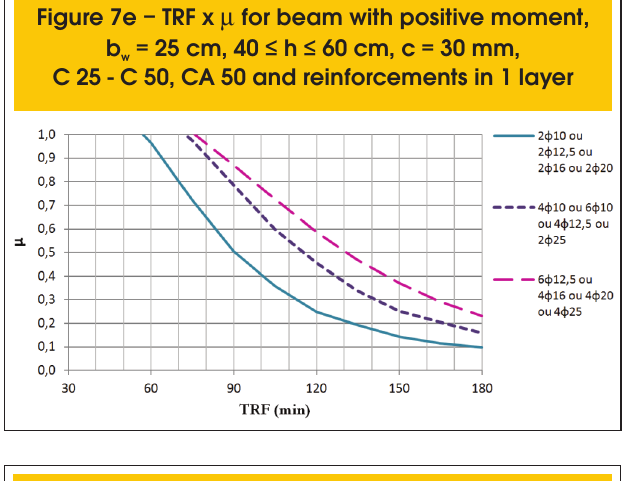
Figure 8c – TRF x m for beam with negative moment, b = 19 cm, 40 ≤ h < 50 cm, c = 40 mm, w C 25 - C 50, CA 50 and reinforcements in 1 layer